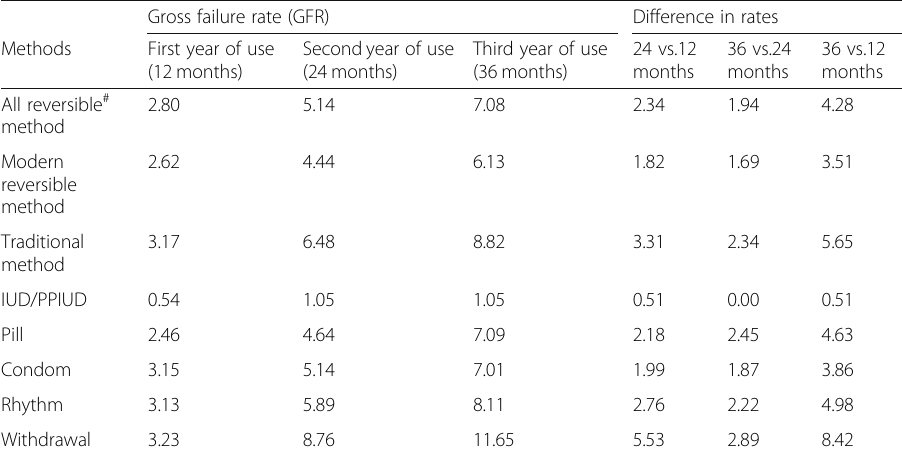
Table 2 Life table 12-month contraceptive failure per 100 episodes for different methods Gross failure rate (GFR) Difference in